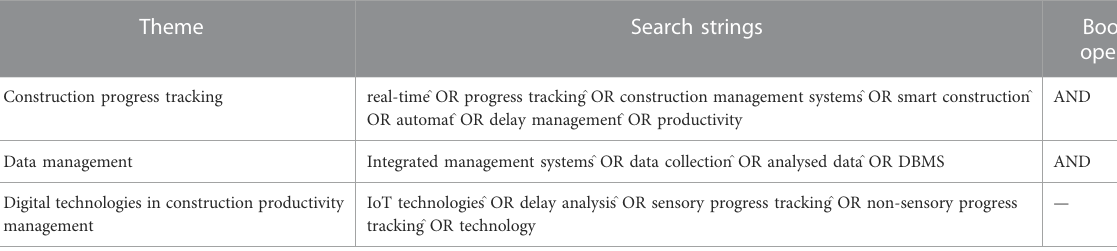
TABLE 1 Research strategy- strings.